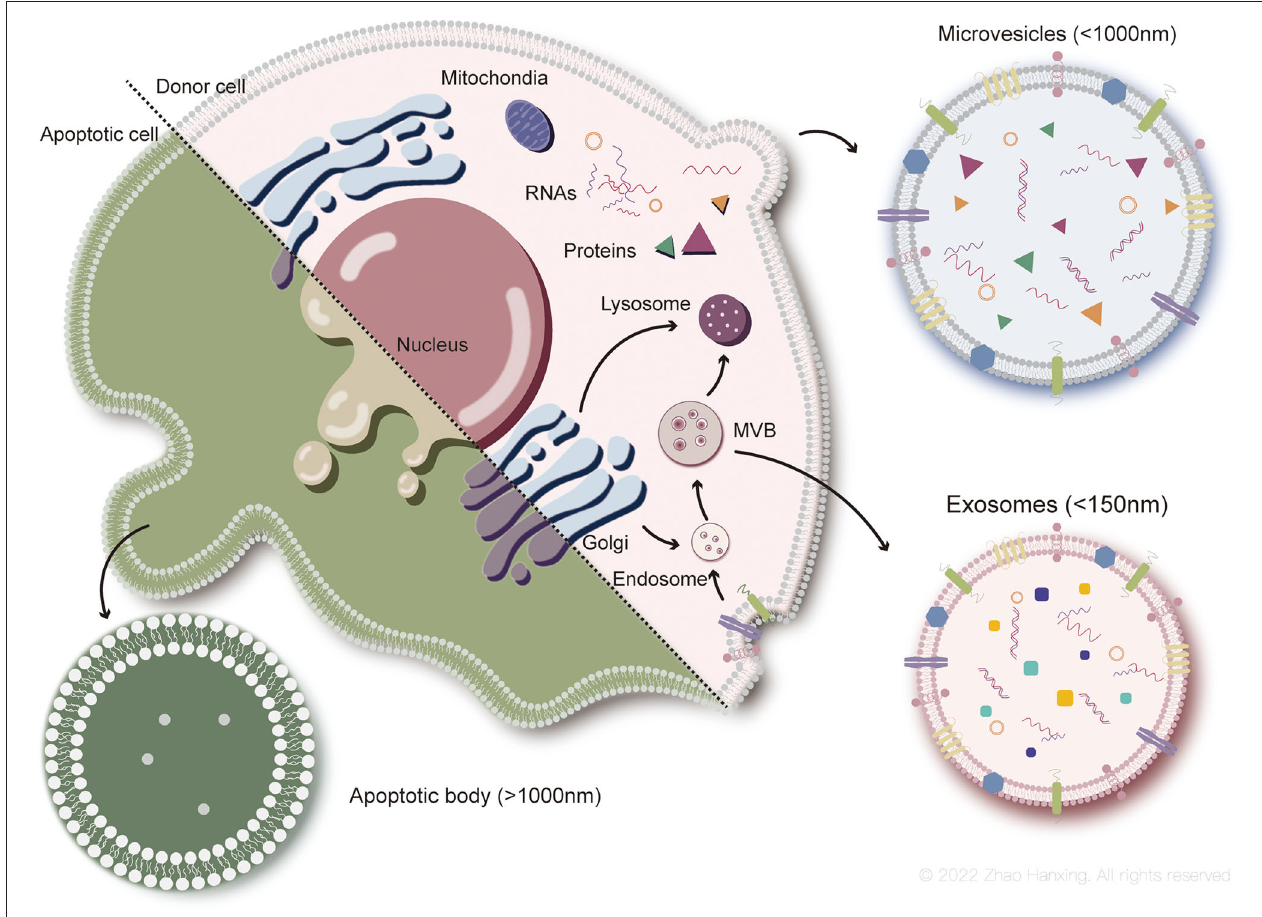
FIGURE 2 | Biogenesis of each subtype of EVs. Exosomes ( < 150nm in size) originate from endosome. Microvesicles (up to 1,000nm) generate from plasma membrane. Apoptotic bodies (more than 1,000nm) are particles of apoptotic cells disassembly.